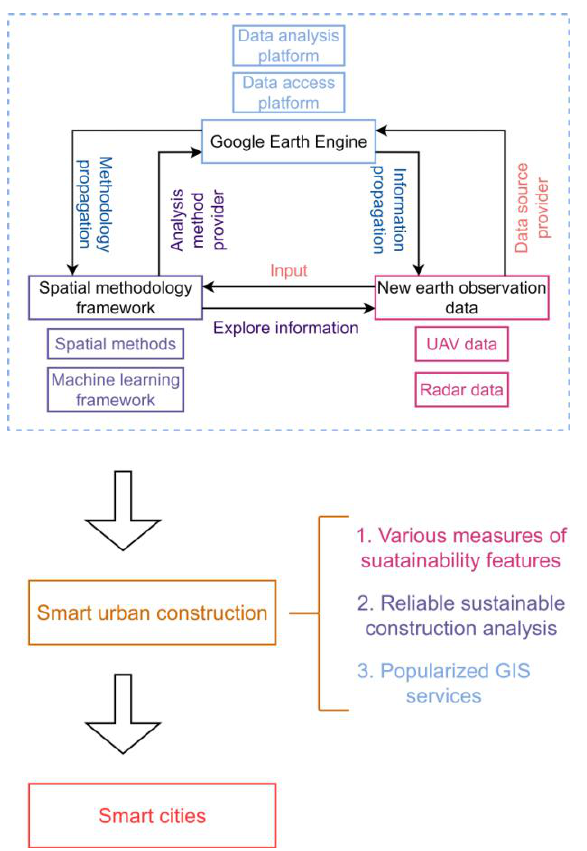
Figure 2. The development of earth observation techniques for a better smart urban construction